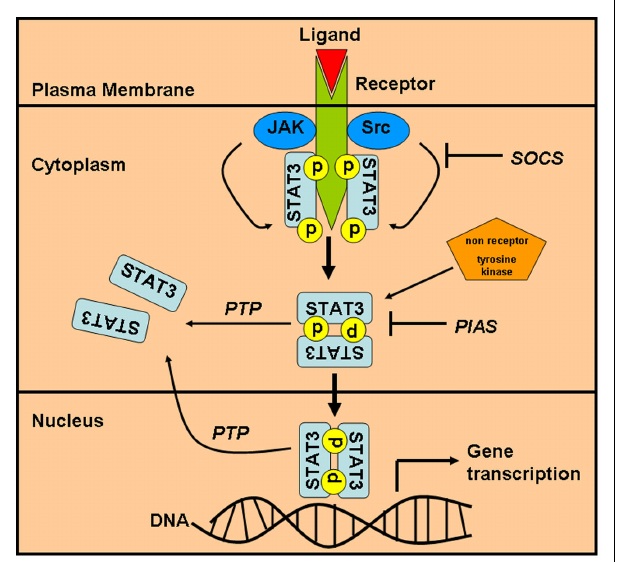
FIGURE 1 |Activation and regulation of the STAT3 signaling pathway. The STAT3 signaling pathway is turned on by the activation of cell surface receptor (growth factor or cytokine receptors) leading to recruitment and activation of JAK-family of proteins, which in turn recruits and phosphorylates STAT3. STAT3 can also be directly phosphorylated by non-tyrosine kinase receptors (Src or c-abl). Phosphorylated STAT3 homodimerizes and translocates to the nucleus where it regulates gene expression.The signaling pathway can be switched off by the actions of a phosphatase which dephosphorylates STAT3 and prevents dimer formation. Also, PIAS and SOCS family of protein can directly compete with STAT3 for either binding opportunities with the activating receptor or for dimerization and translocation into the nucleus. STAT3, signal transducers and activators of transcription 3; JAK, Janus kinase; SOCS, suppressors of cytokine signaling; PTP, protein-tyrosine phosphatase; PIAS, protein inhibitor of activated